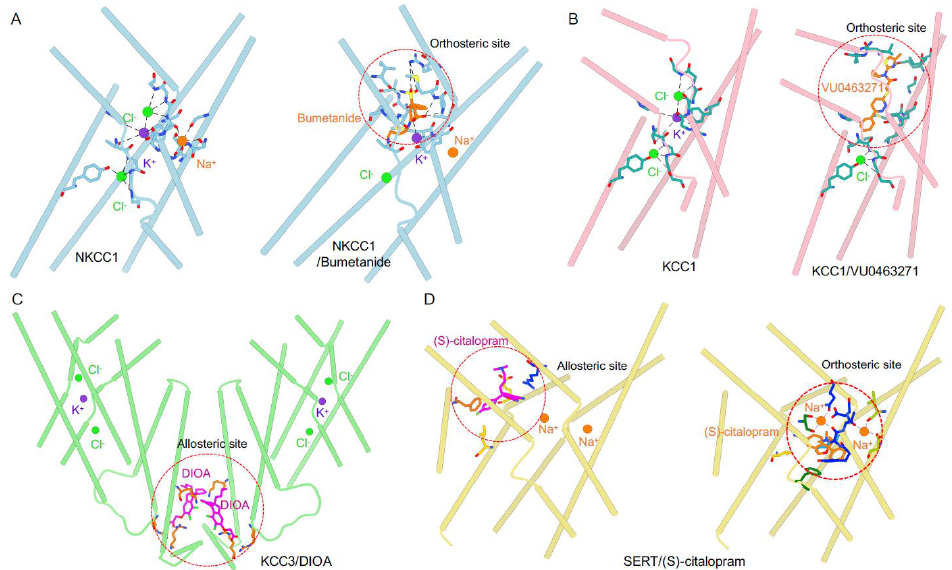
Figure 3. Receptor sites for CCCs and serotonin transporter (SERT) modulators. ( A , B ) Bumetanide and VU0463271 act as orthosteric inhibitors of NKCC1 and KCC1, respectively. ( C ) DIOA may be an allosteric inhibitor of KCCs. ( D ) (S) − citalopram binds to both allosteric and orthosteric sites on SERT. Small molecule inhibitors are rendered as sticks; ions are shown as spheres.